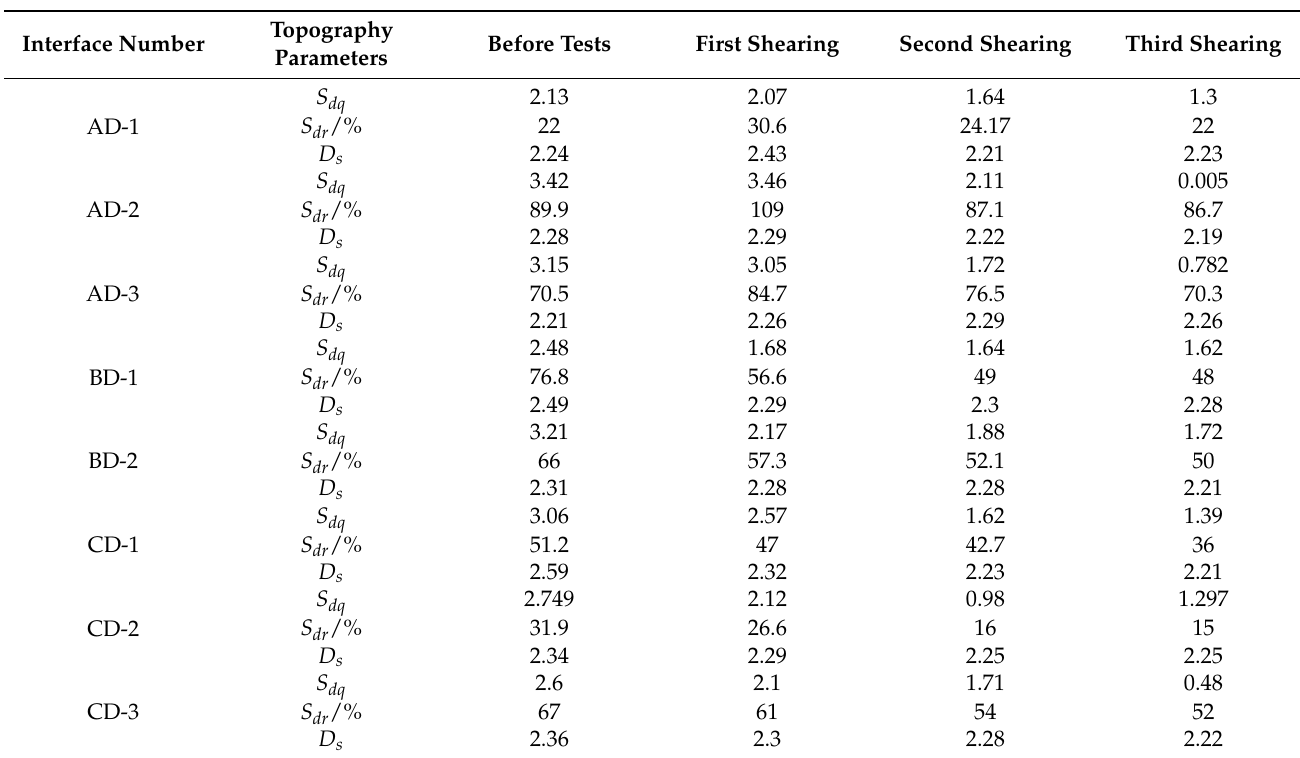
Table 6. Mixed feature parameter changes of surface